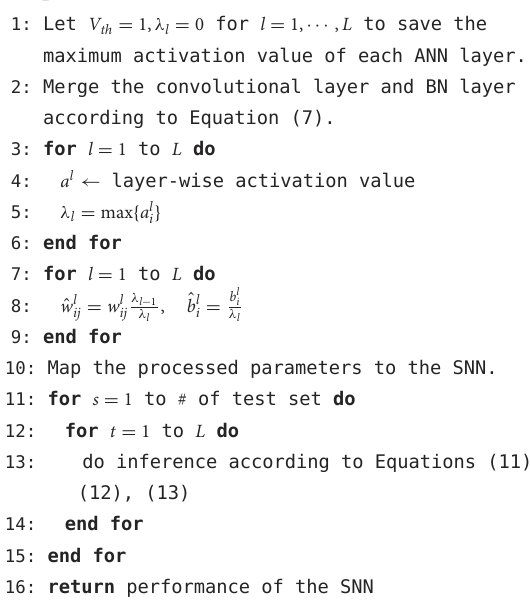
Algorithm 1. ANN-SNN conversion with BIF